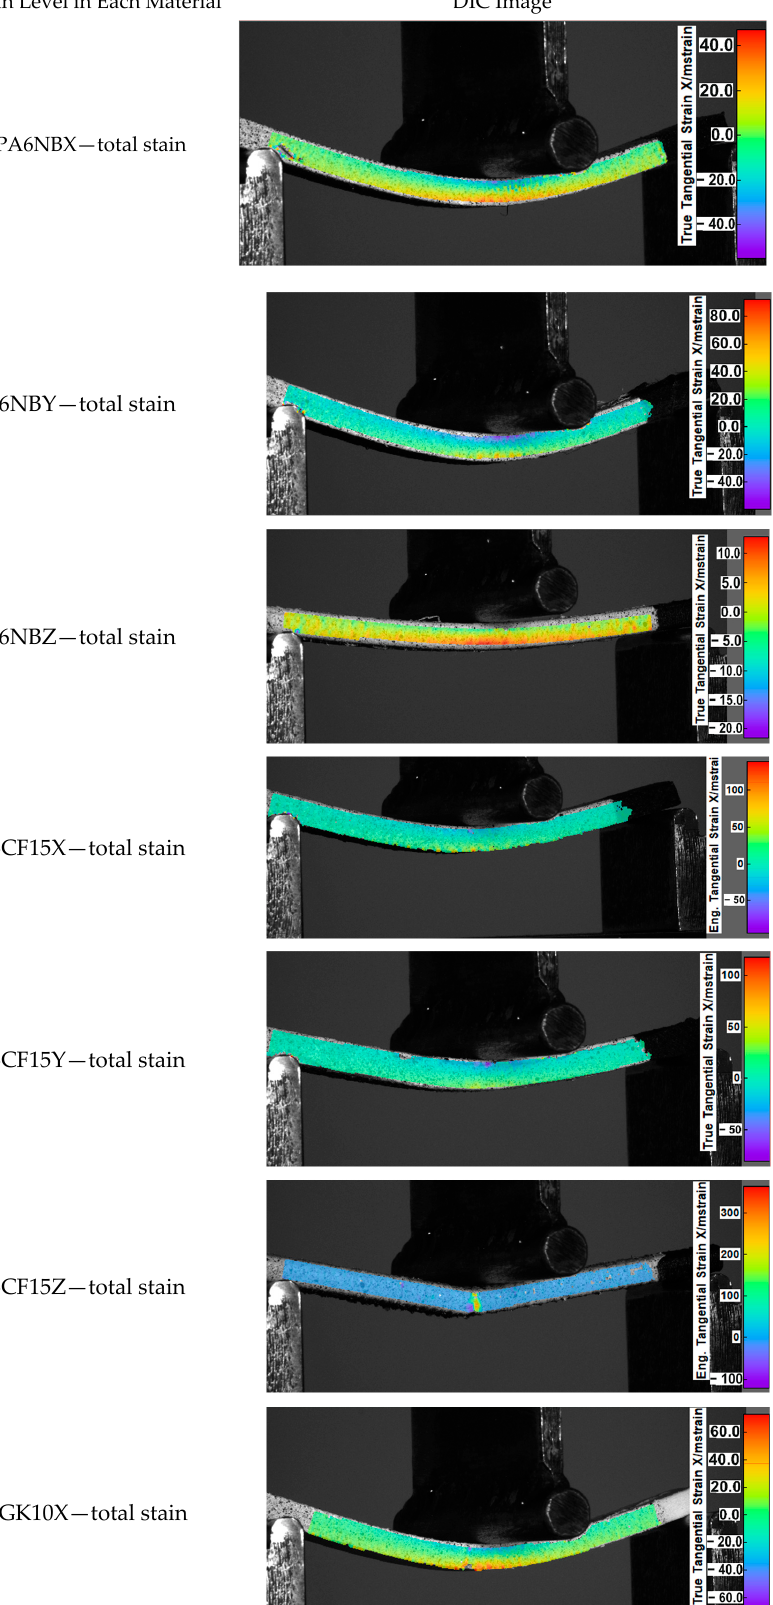
filling. Instead, in the case of samples produced in the Z direction, the load was carried on